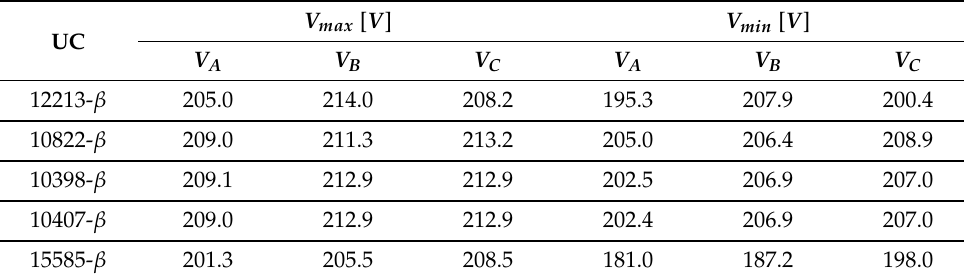
Table 12. feeder- β maximum and minimum voltage with pf = 0.9.